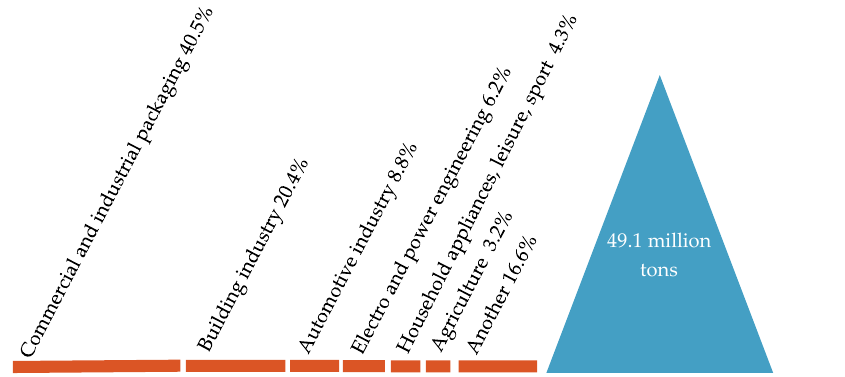
Figure 6. Demand for plastics in the EU27 + 3 by application segments. Made based on [3].